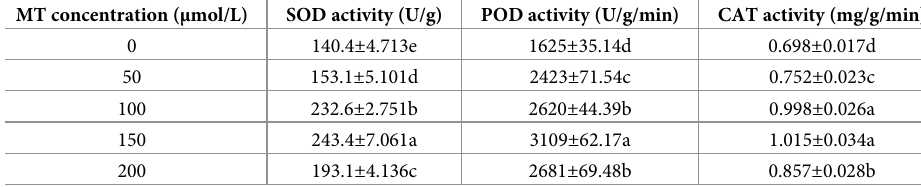
Table 4. Antioxidant enzyme activity in grape seedling